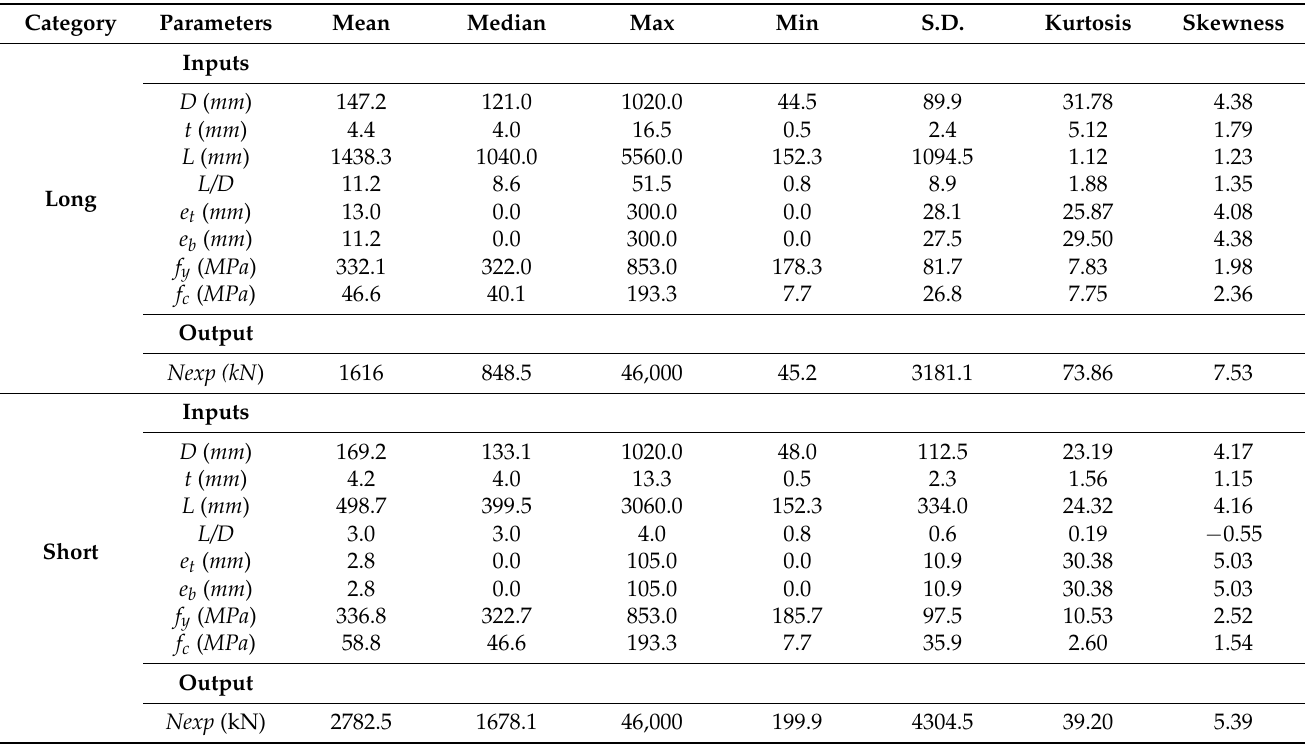
Table 1. Descriptive statistical analysis of explanatory variables and